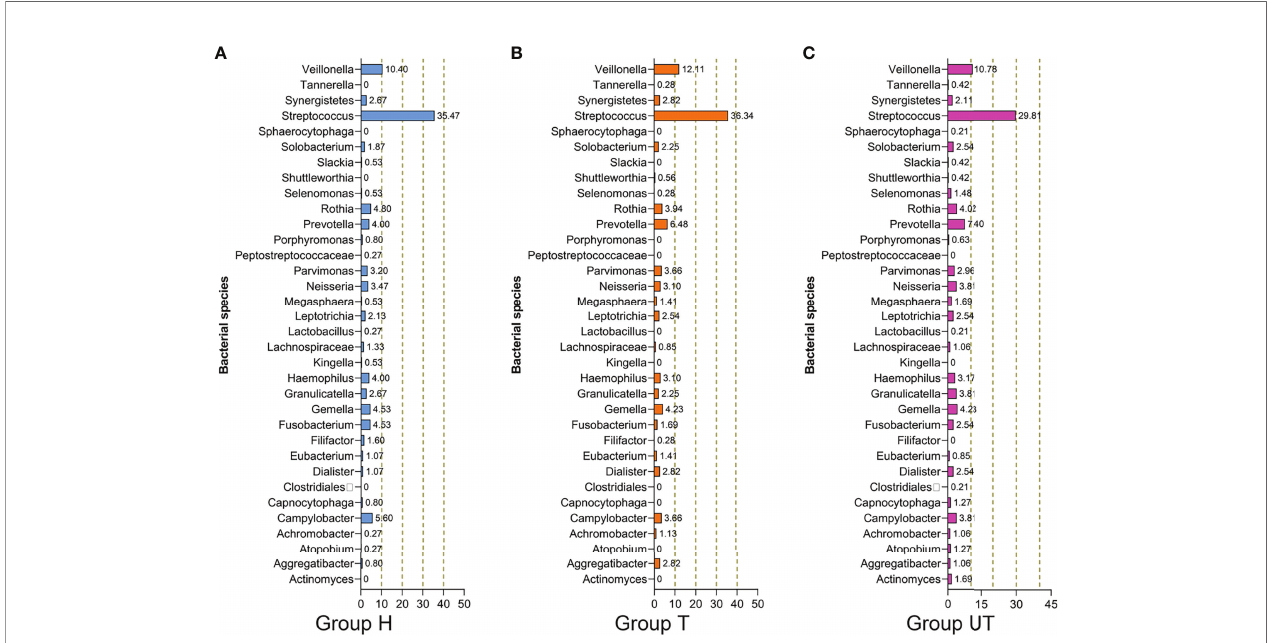
FIGURE 3 | Species composition and distribution of fl ora in saliva samples from HIV-infected/AIDS patients after HAART at the genus level. Proportional distribution of major bacterial genus in the healthy control, HAART unprocessed, and HAART groups. (A) Bacterial species in Group H. (B) Bacterial species in Group T. (C) Bacterial species in Group UT. Group H, Healthy control; Group T, After treatment of HAART-processed AIDS patients; Group UT, Before treatment of HAART- processed AIDS